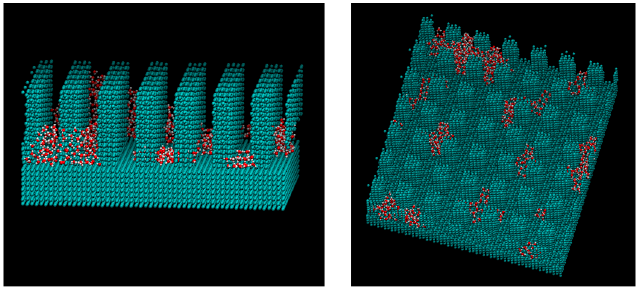
Figure 9. Snapshot of water molecules during the condensation on the ε = 19.74. kJ/mol surface from the different viewpoints. The water molecules are adsorbed into the pillar and formed water film.